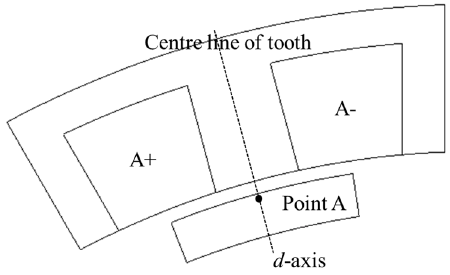
Figure 6. Points chosen for demagnetization analysis within the PM.